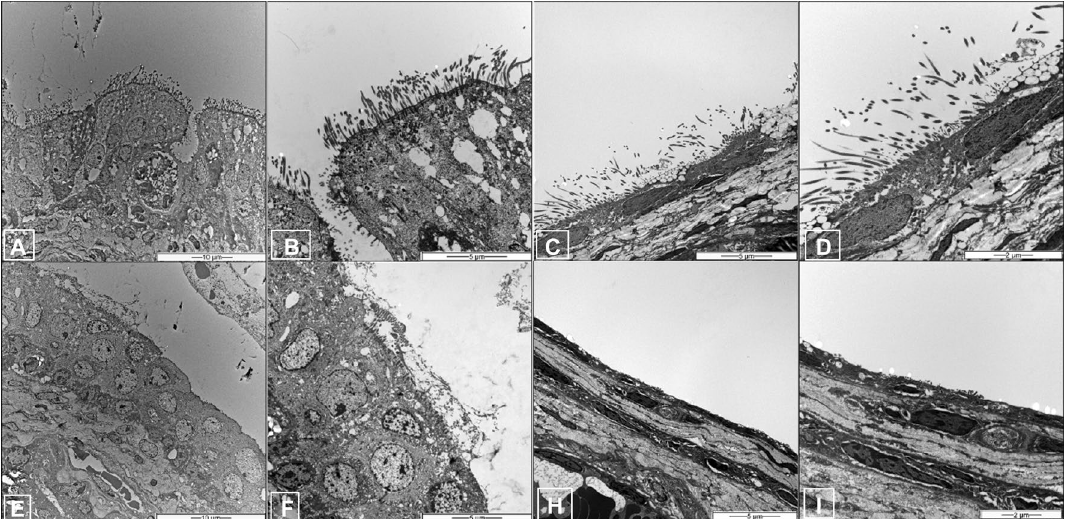
Figure 6. Ultrastructural findings of the Eustachian tube ( A , B , E , F ) and middle ear ( C , D , G , H ) in the control group. Normal cilia are observed in the Eustachian tube and middle ear. ( A ) ×2000 magnification. ( B ) ×6000 magnification. ( C ) ×5000 magnification. ( D ) ×10,000 magnification. Ultrastructural findings of the Eustachian tube and middle ear after 2 weeks of exposure to cigarette smoke. Severe loss of cilia and neutrophilic infiltration of the epithelium are observed. ( E ) ×2000 magnification. ( F ) ×5000 magnification. ( G ) ×5000 magnification. ( H ) ×10,000 magnification.